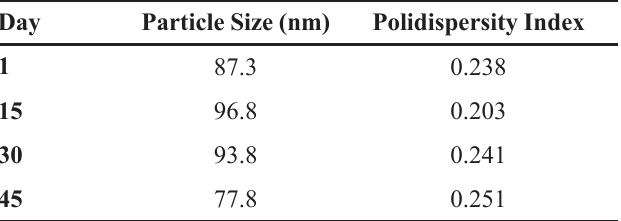
at room temperature EQ1